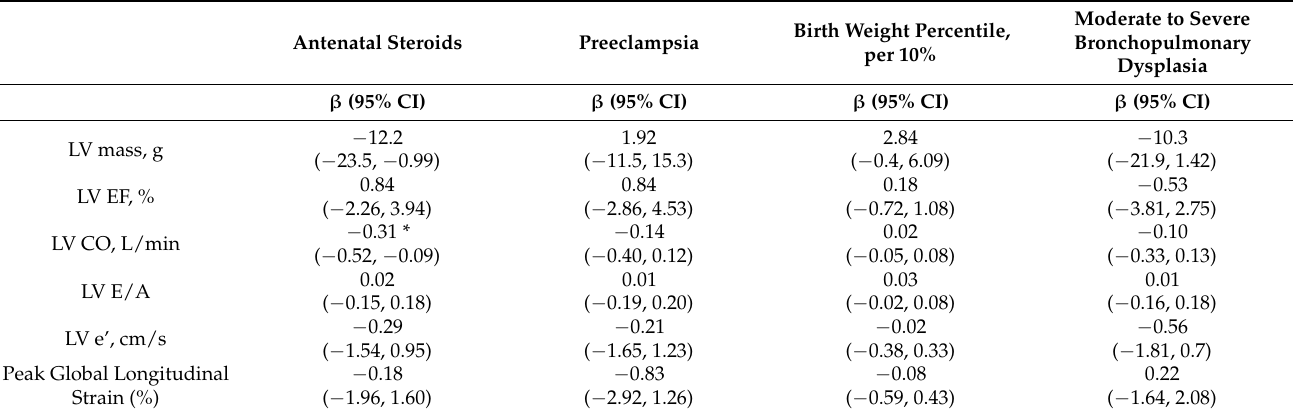
Table 5. Effect of neonatal factors on preterm adult left heart structure and